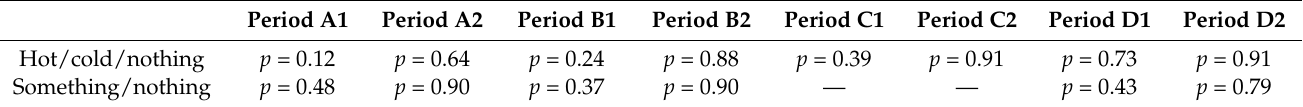
Table 11. Difference of TSV based on food